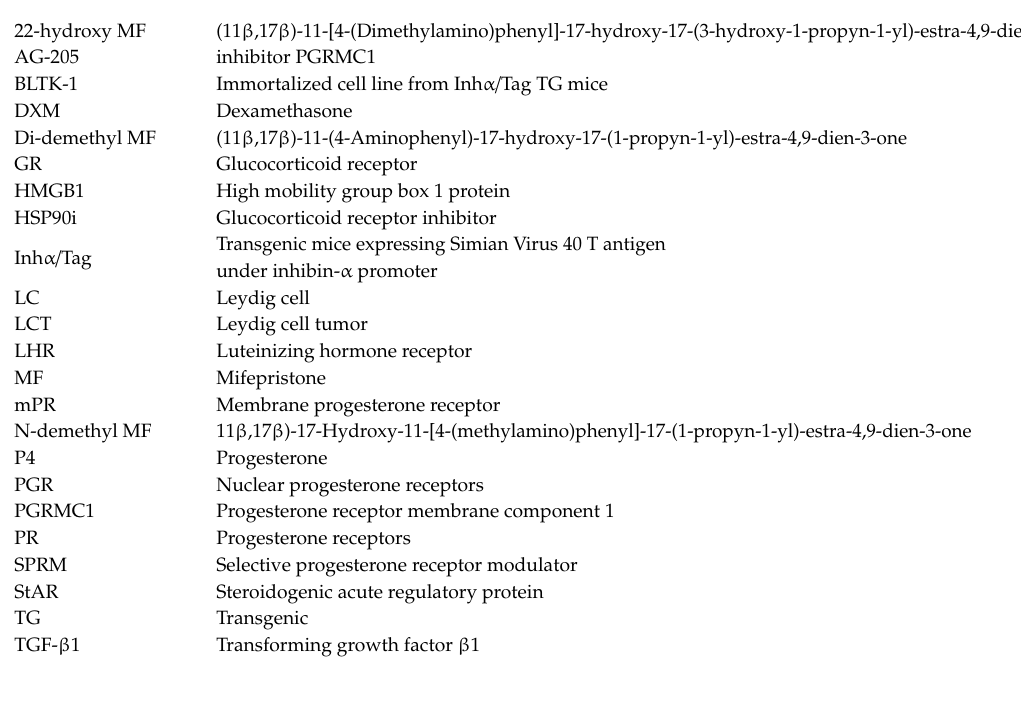
Figure S1: Pharmacokinetic analysis of MF metabolism in Inh α / Tag TG mice, Figure S2: Proliferation of mLTC-1 cells with MF or P4 treatments, Figure S3: Lhcgr expression level in Leydig cell tumors of Inh α / Tag TG mice, Figure S4: Characteristics of progesterone receptors mRNA levels in BLTK-1 and mLTC-1 cell lines, Figure S5: MF and P4 treatments e ff ects on glucocorticoid receptor, Figure S6: Gr-target genes expression profile in BLTK-1 cells, Figure S7: MF and P4 treatments e ff ects on androgen receptor expression, Figure S8: SV40 Tag expression level in Inh α / Tag TG mice and BLTK-1 cells, Figure S9: Isotype negative control staining, Table S1: Characteristics of progesterone receptors mRNA level and immunoreactivity in murine Leydig cell tumor and murine Leydig tumor cell line, Table S2: Primer sequences for